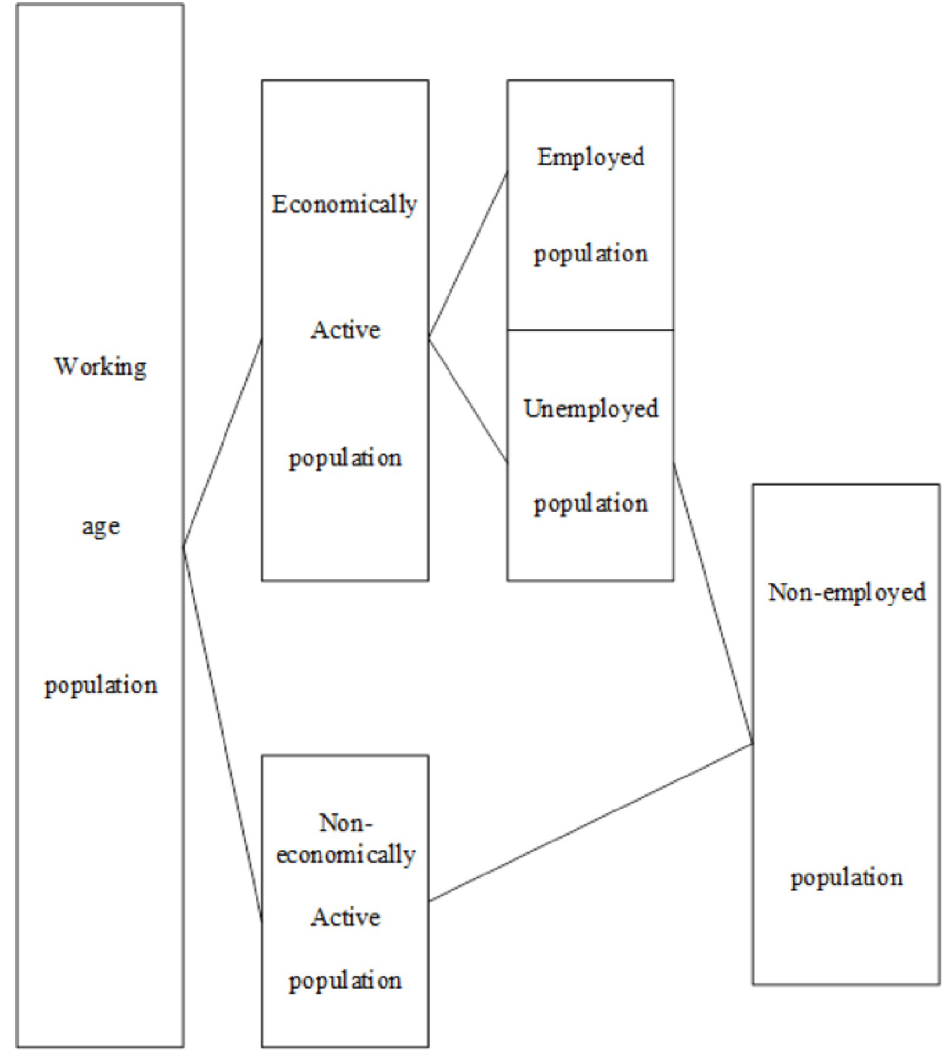
Fig 1. Classification of working-age population according to the international labor